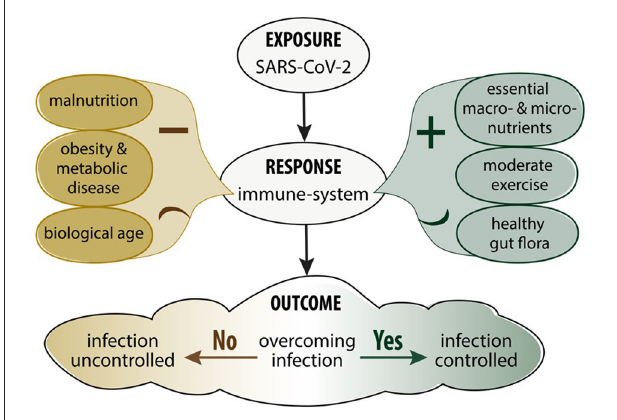
FIGURE 1 | Impact of nutrition, metabolic disease and exercise on the immune response and SARS-CoV-2